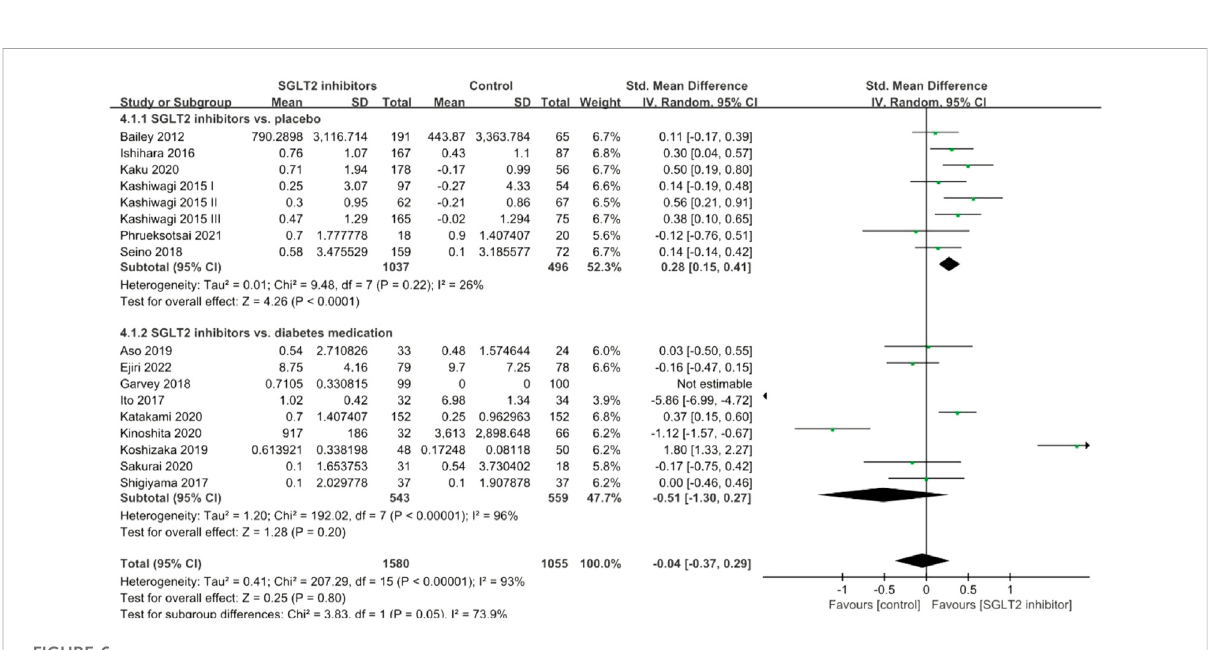
Forest plot of the effects of SGLT2 inhibitors on